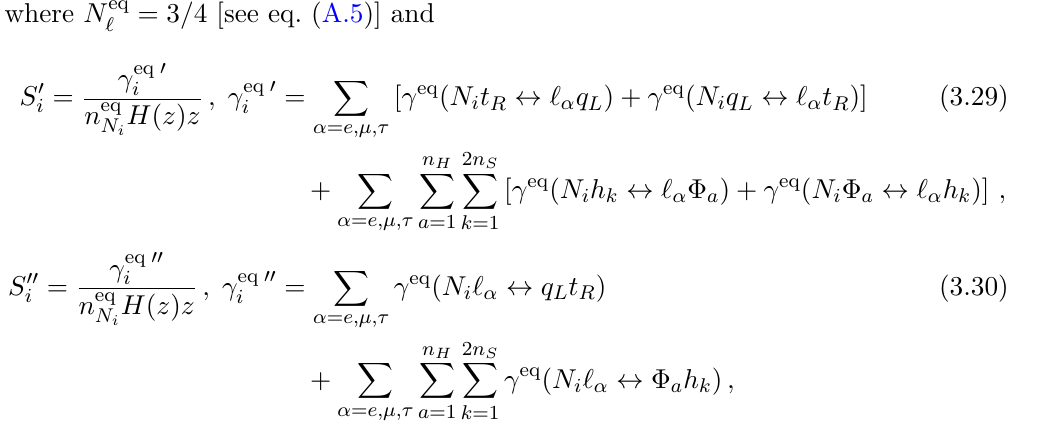
where N eq = 3 / 4 [see eq. (A.5)] ‘